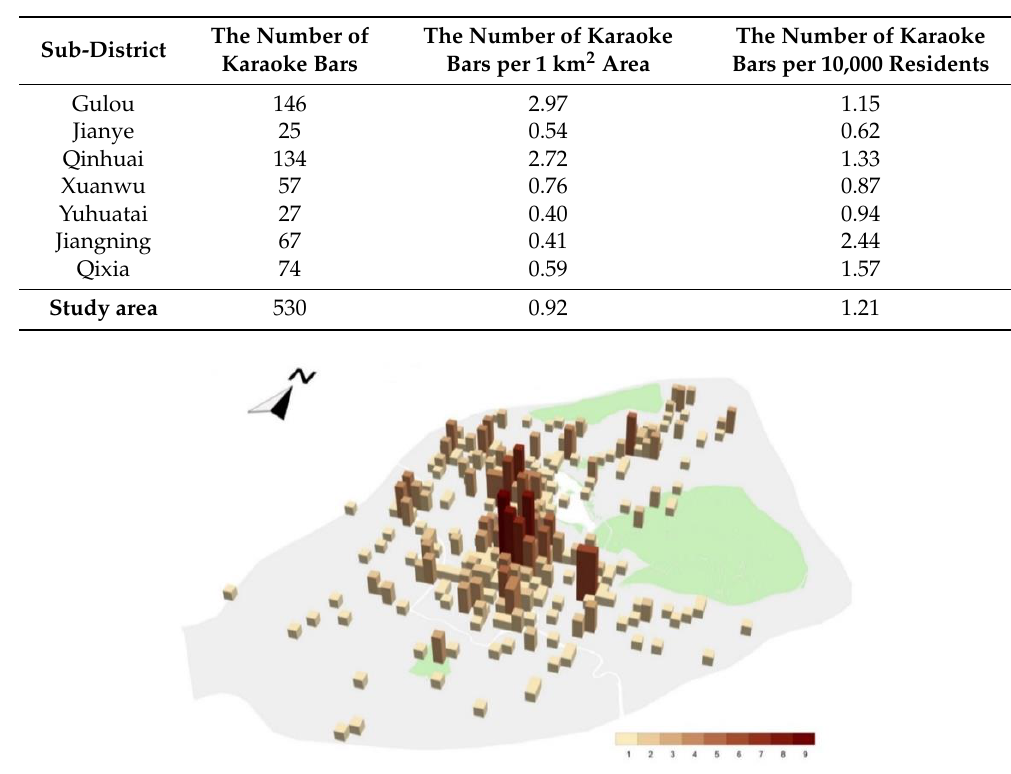
Table 1. The number and density of karaoke bars in study area.